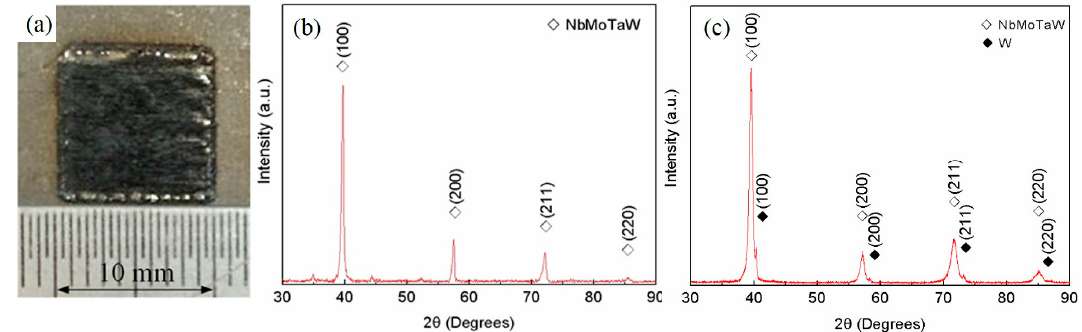
Figure 3. X-Ray powder diffraction (XRD) patterns of NbMoTaW HEA parts and results. ( a ) Patterns of NbMoTaW high-entropy alloy (HEA) parts fabricated by SLM. ( b ) XRD result with one alloy structure, ( c ) XRD result with alloy and a small amount of the other tungsten phase.